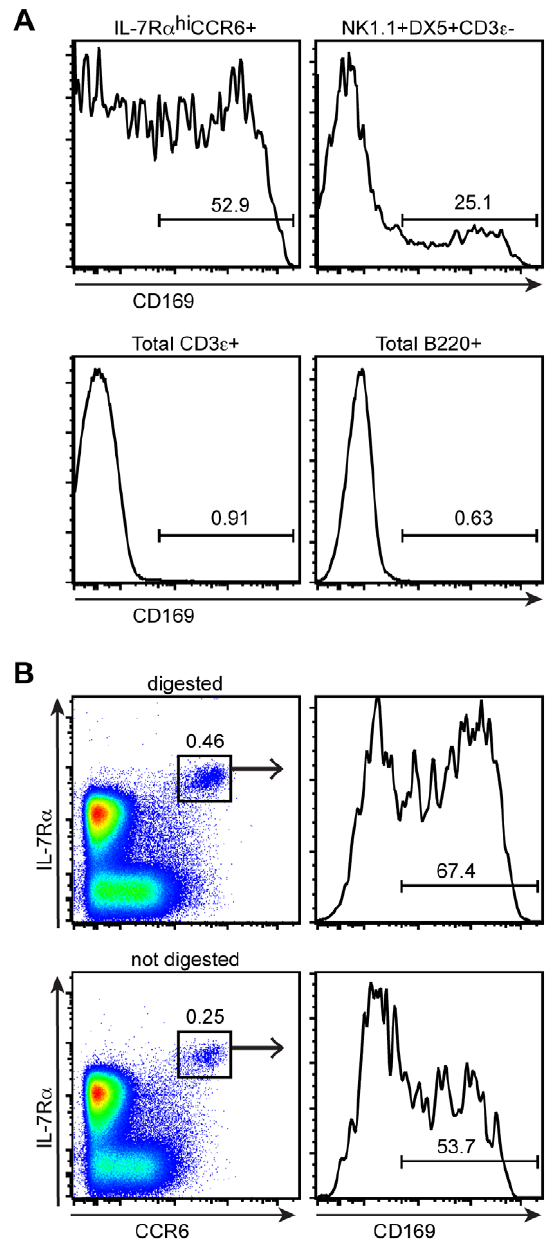
Figure 4. CD169 bleb + cells are enriched for IL-7R a hi CCR6 + cells and NK cells. (A) Flow cytometric detection of CD169 on digested lymph node cells gated on IL-7R a hi CCR6 + cells, NK1.1 + DX5 + CD3 e 2 cells, CD3e + cells, and B220 + cells. (B) Flow cytometric detection of CD169 on IL-7R a hi CCR6 + cells from digested (top panel) or non-digested (bottom panel) lymph nodes. All data are representative of at least two independent experiments.